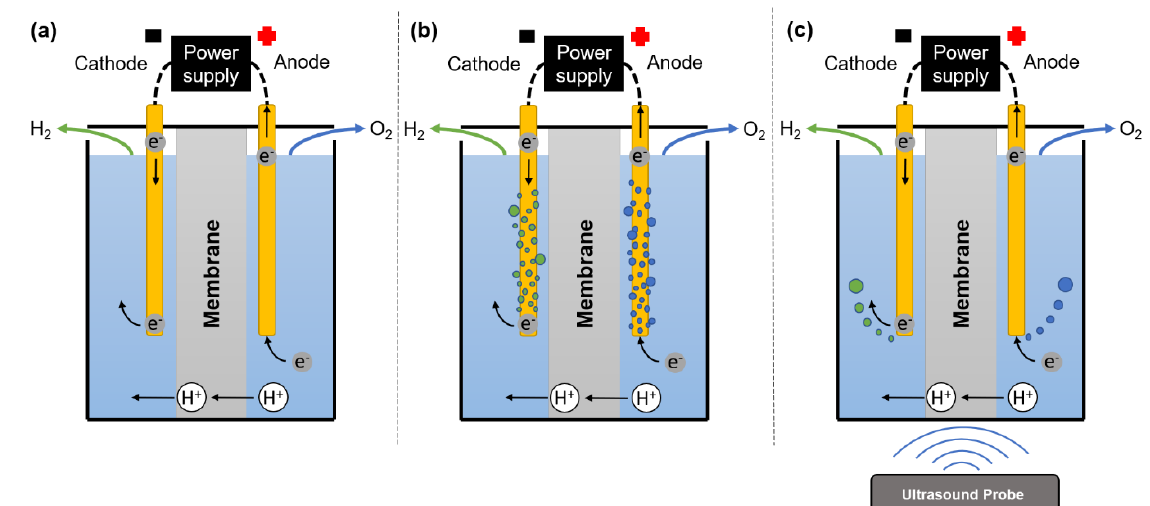
Figure 3. A simplified water electrolyzer (containing a protonic conducting membrane) showing the HER at the cathode and the OER at the anode, subjected to ultrasound. ( a ) DC applied, ( b ) DC applied and oxygen and hydrogen bubbles produced at the anode and cathode, respectively, ( c ) DC and ultrasonic applied leading to effective removal of gas bubbles from the electrode surfaces.